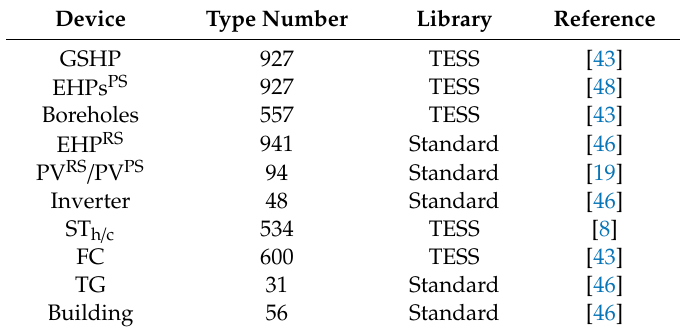
Table 4. Main device, type number, libraries and reference for description / validation models. Device Type